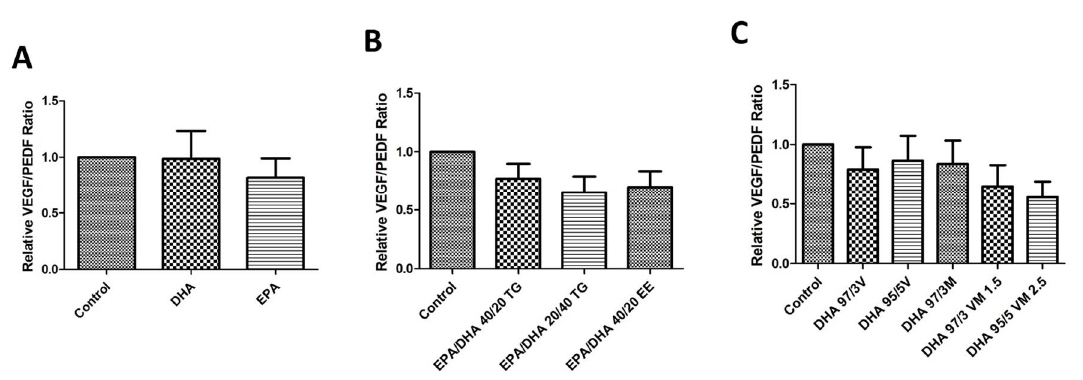
Figure 7. Graphs showing relative VEGF/PEDF ratio ( A–C ) results for ARPE-19 cells treated with different groups 1, 2, and 3 of DHA/EPA formulations, respectively. For comparisons, one-way ANOVA with the Bonferroni post-hoc test were used. Data are expressed as mean ± SEM. EPA: Eicosapentaenoic acid; DHA: Docosahexaenoic acid; TG: Triglycerides; EE: Ethylesters; PL: Phospholipids. V: Vegetable. M: Marine.